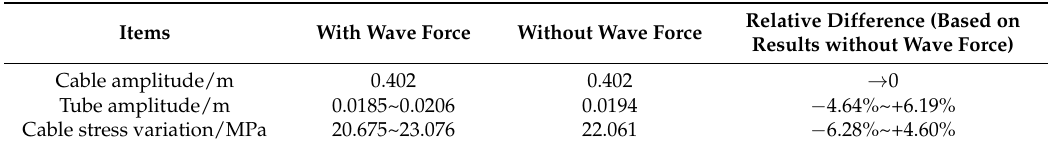
Table 2. Calculation results of the steady resonance state due to vortex-induced vibration (VIV) of the